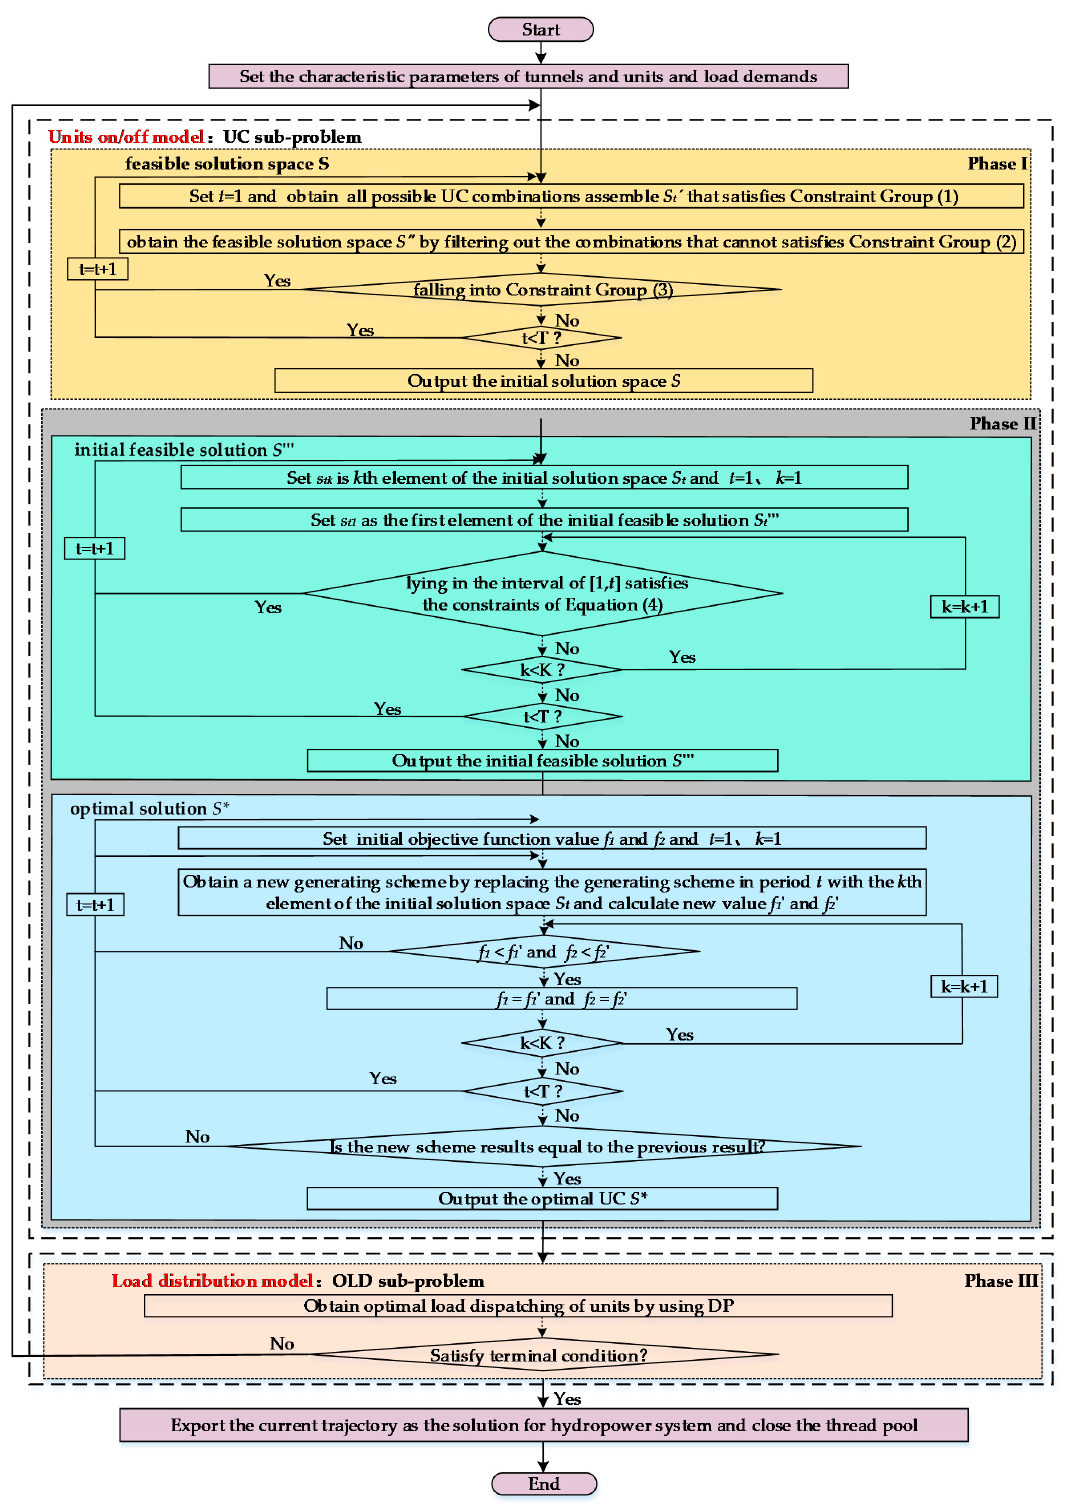
Figure 2. Flowchart of two-phase decomposition approach for solving short-term load dispatching (STLD).